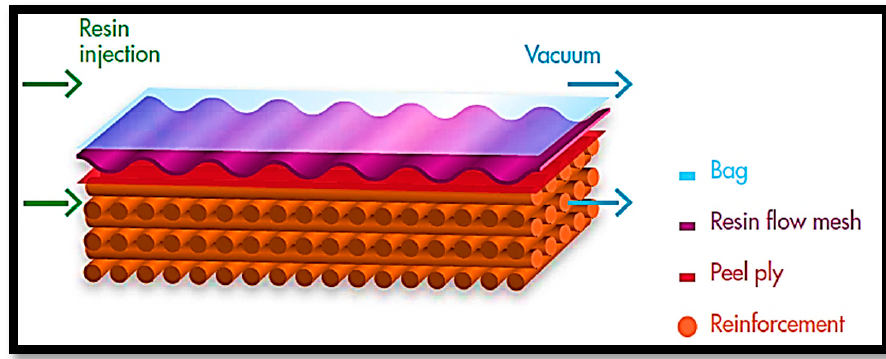
Figure 3. Vacuum infusion process technique of GFRP sandwich composites [61].